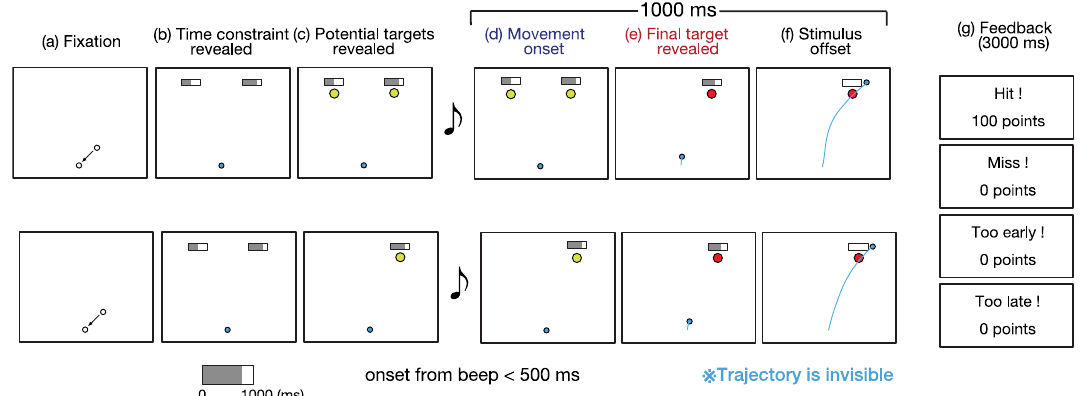
Figure 1. Sequence of the experimental task. The top row shows the double-target condition. The bottom row shows the single-target condition. ( a ) First, participants move the cursor to the start position. ( b ) After the presentation of the time constraint indicator, ( c ) the potential targets are presented. ( d ) 450–1000 ms later, participants were required to start the movement after the sound stimulus. After the movement onset, the gray area of the indicator reduces linearly with time. ( e ) When the participant’s movement onset is detected, the final target is presented. ( f ) The stimulus disappeared 1000 ms after the movement onset. Participants acquired 100 points if they met the movement onset criteria and passed the final target within the time constraint assigned to the final target. ( g ) Feedback on successes, failures, and scores was provided after each